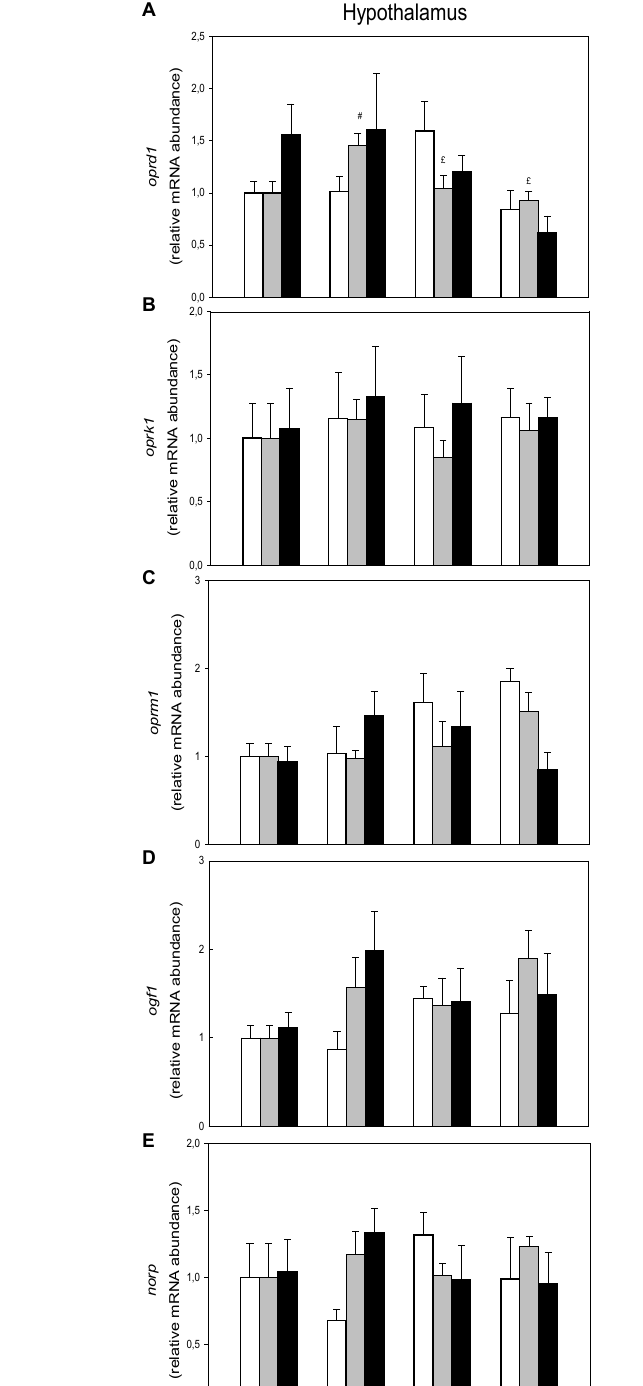
Frontiers in Physiology |